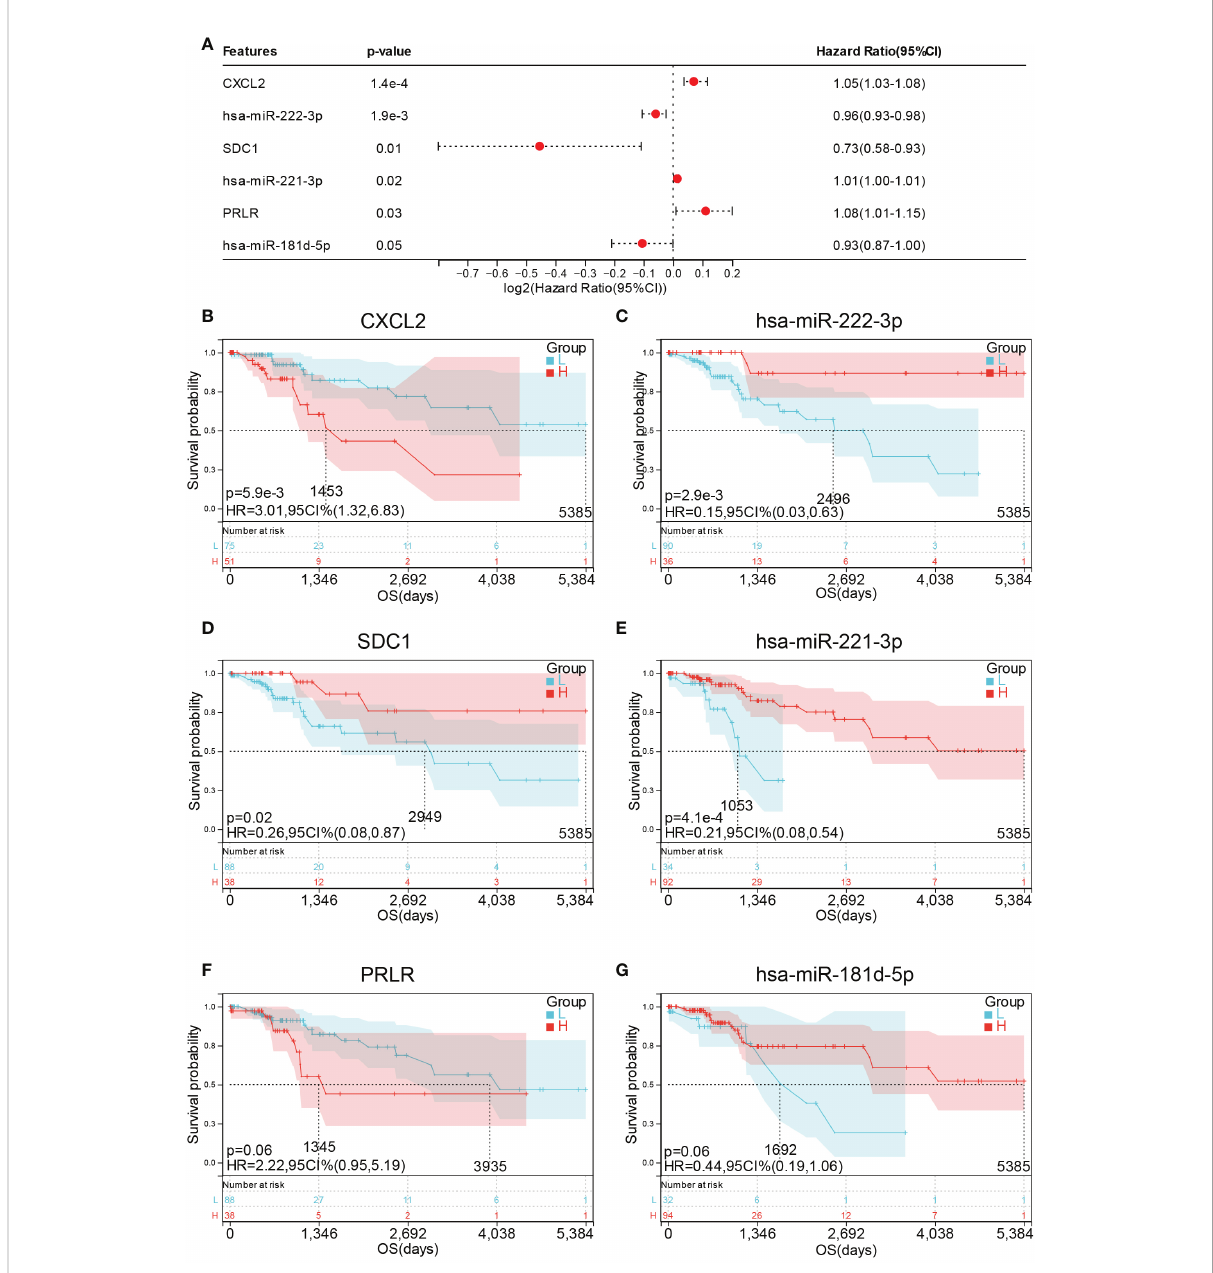
FIGURE 11 Prognostic values of hub genes in CESC patients. (A) forest plot of 6 hub genes in TCGA-CESC cohort. Prognostic value of (B) CXCL2 (C) miR- 222-3p (D) SDC1 (E) miR-221- 3P (F) PRLR and (G) miR-181d-5p in TCGA-CESC